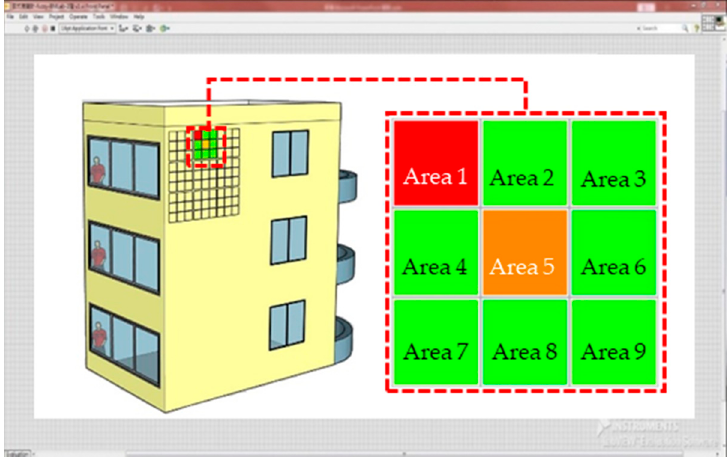
Figure 14. S4 monitoring screen.